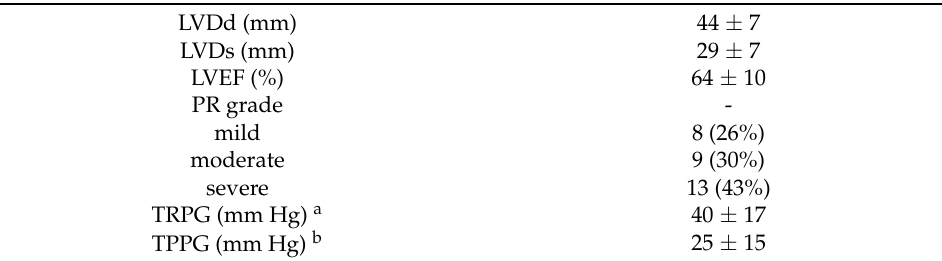
Table 3. Transthoracic echocardiographic data.